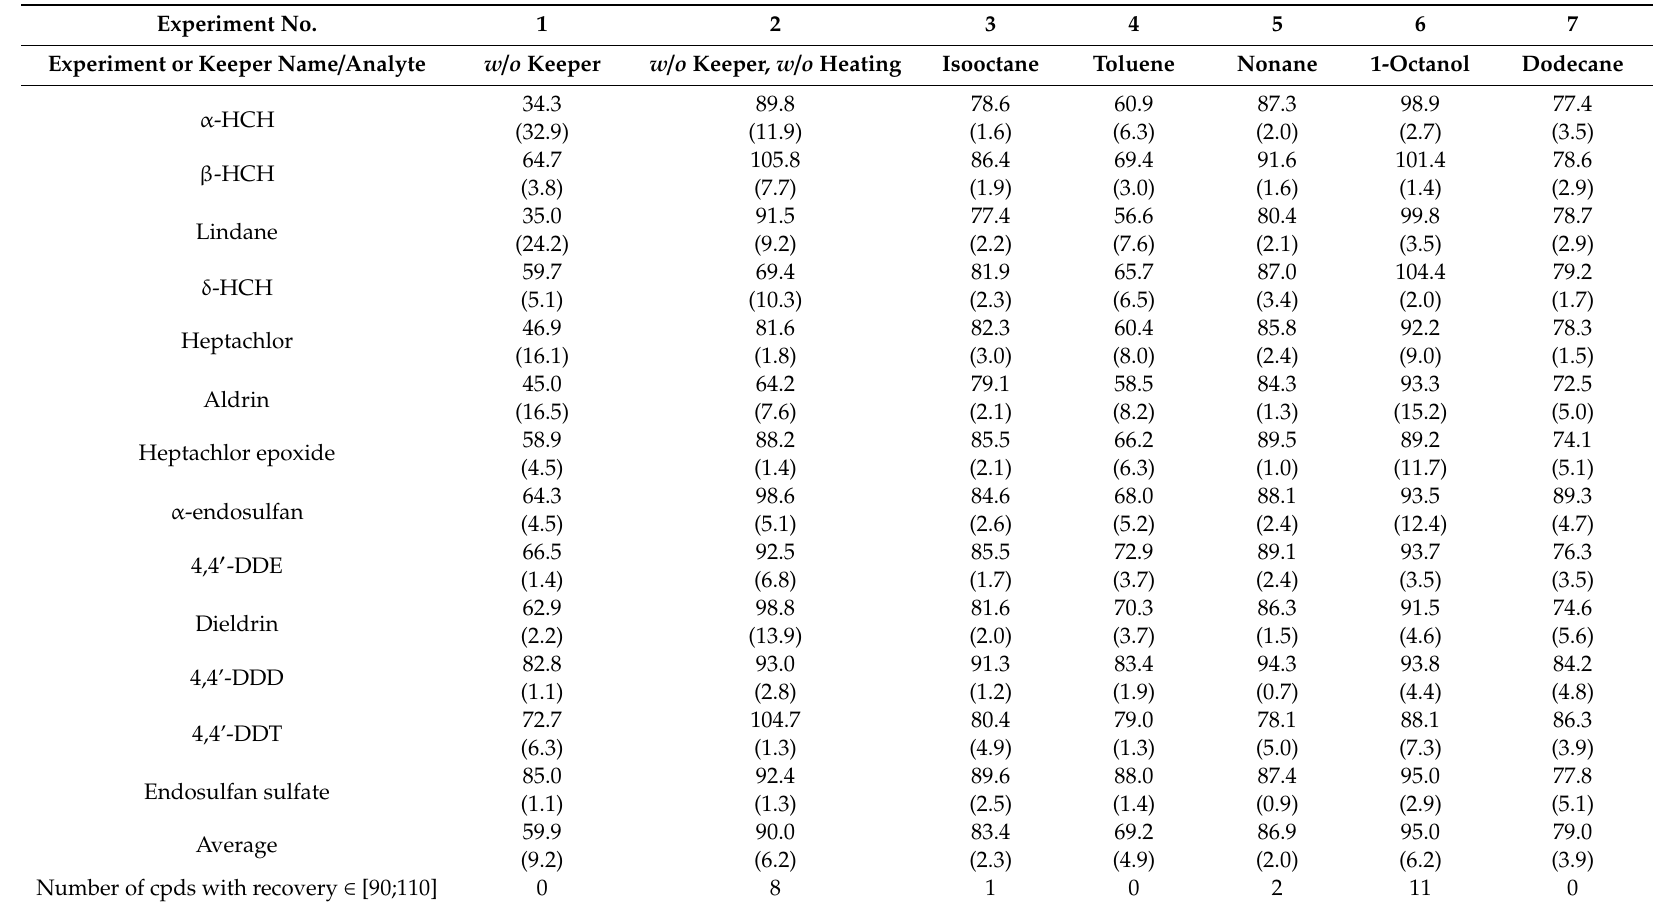
Table 2. Recoveries and RSDs (%) achieved in organochlorine pesticide (OCP) evaporation experiments. Experiment